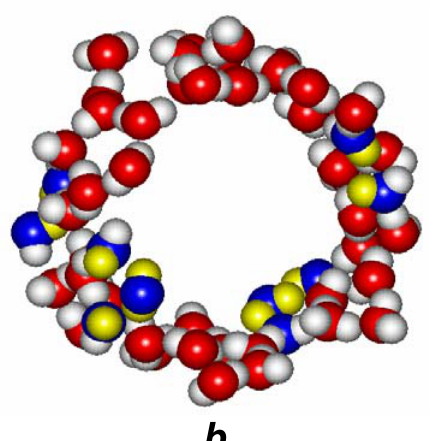
a b Figure 5. The inner ( a ) and outer ( b ) clusters formed by water molecules for a (6,6) nanotube immersed in water. BD and ID associates in outer clusters are marked by color. CN is not